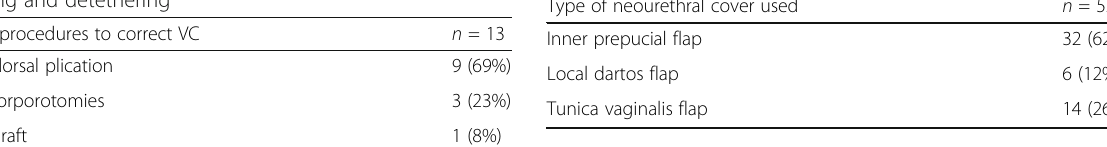
Table 5 The auxillary procedures employed to correct VC after degloving and detethering